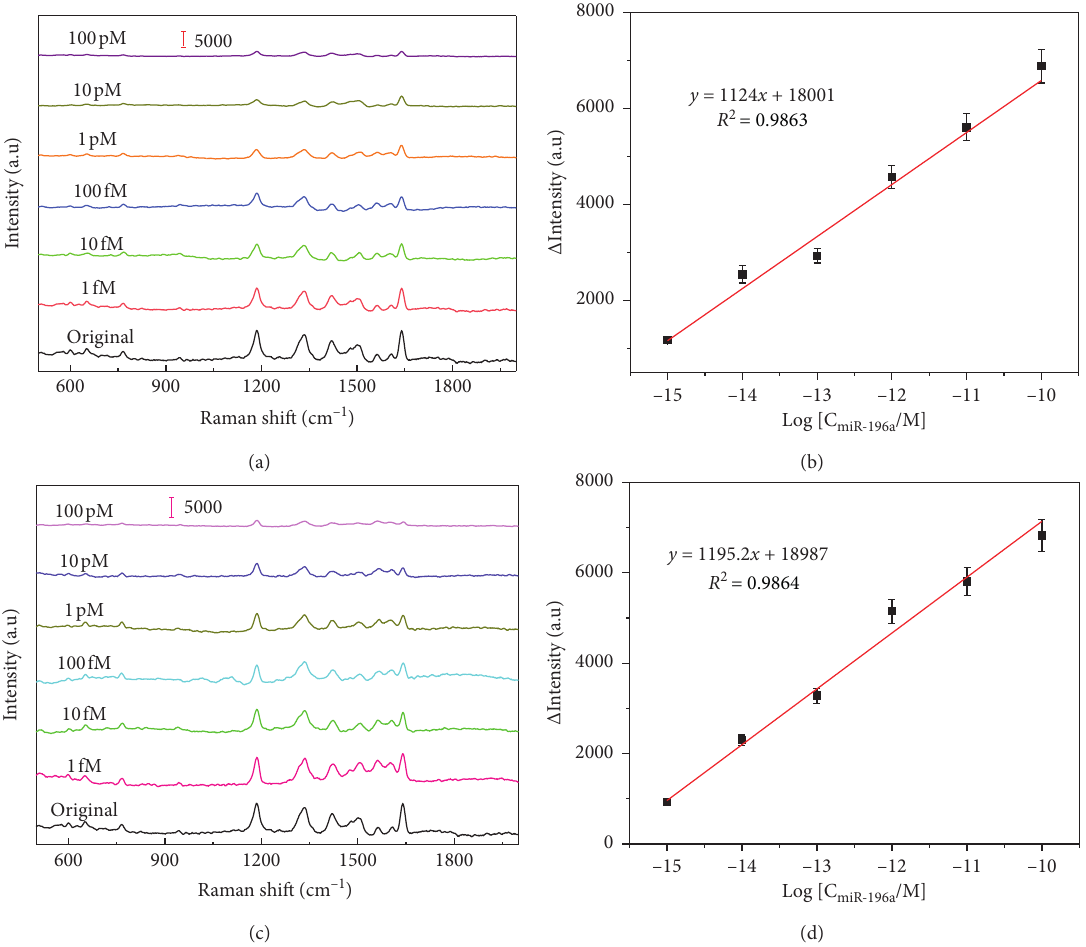
Figure 5: (a) SERS spectra of 5-FAM obtained before and after hairpin DNA hybridization at various concentrations of miR-196a in PBS. (b) The calibration curve of SERS intensities of Δ I 1334 versus the miRNA concentration in PBS buffer. (c) Corresponding SERS spectra of 5- FAM collected before and after hairpin DNA hybridization by various concentrations of miR-196a in serum. (d) The calibration curve of SERS intensities of Δ I 1334 versus the miRNA concentration in serum. The red scale bars represent 5000a.u. Table 3: Comparison of the AgNW@AuNPs assembly-based SERS platform to other SERS miRNA probes with signal amplification. Detection target LOD (fM) Linear